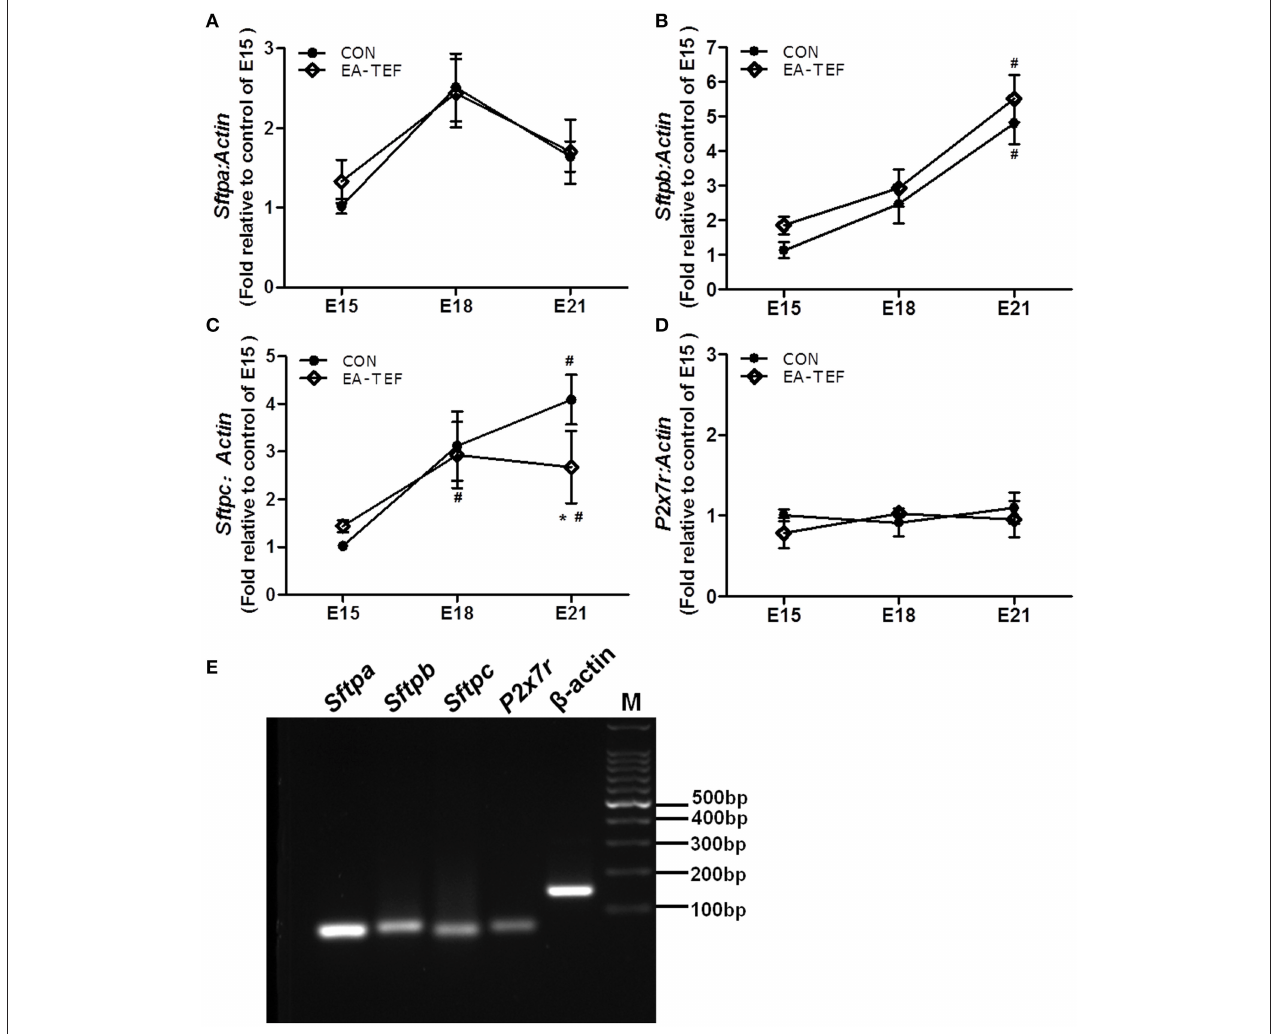
FIGURE 3 | Effect of doxorubicin on expression of epithelial markers in fetal lungs. (A–D) P2x7r, Sftpa, Sftpb , and Sftpc mRNA expression in both groups was assayed by quantitative PCR, and (E) the specificities of the PCR products were confirmed in 2% agarose gels. Expression is relative to an E15 control and normalized against a β -actin housekeeping gene. Data are means ± SEM of five rats, * P < 0.05, EA-TEF vs. age-matched controls, between group; # P < 0.05, E18 or E21 vs. E15, within group. In (C) , the data of Sftpc -control -E15 is (1.019 ± 0.092), the corresponding error bars is too small to display.